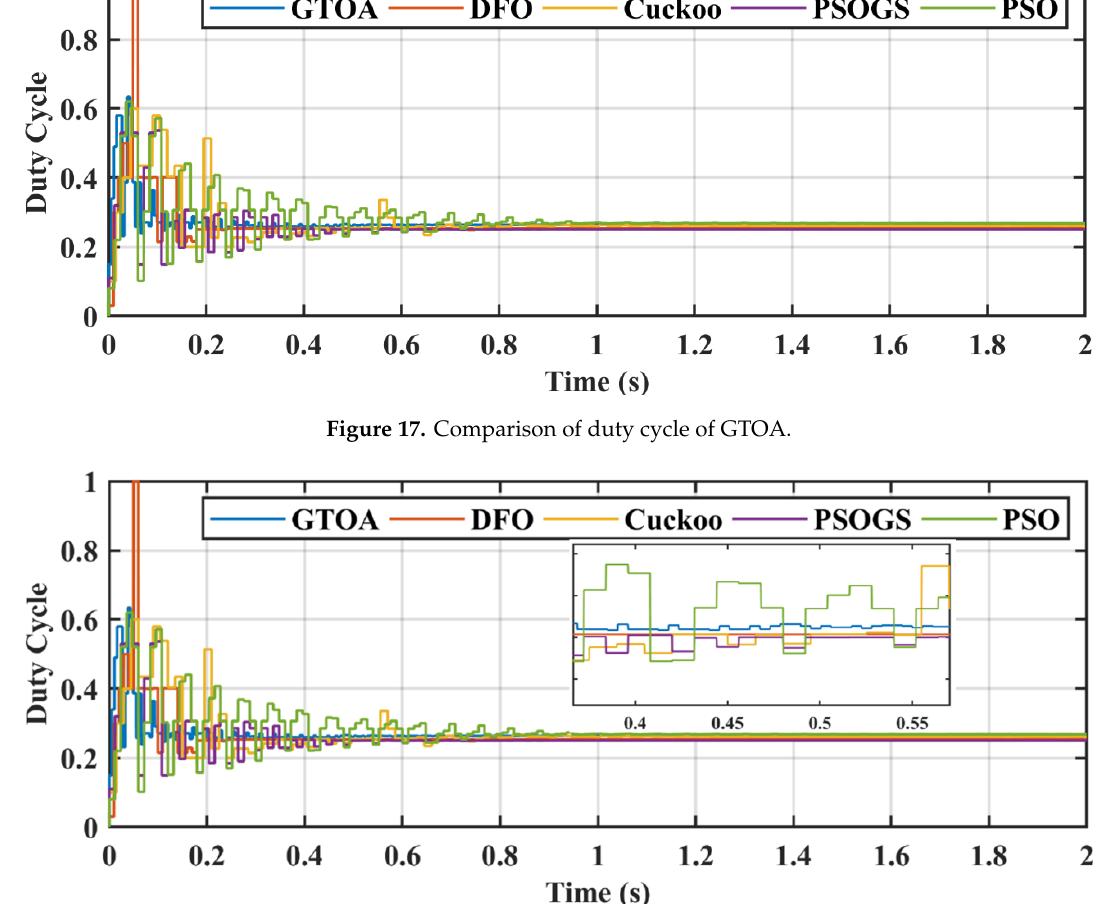
Figure 18. Zoomed-in comparison of duty cycle of GTOA.